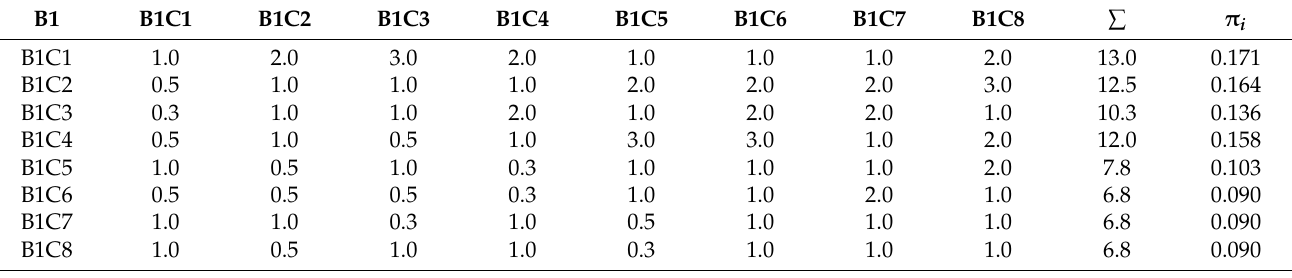
Table 7. Matrix of pairwise comparisons (Level 3).